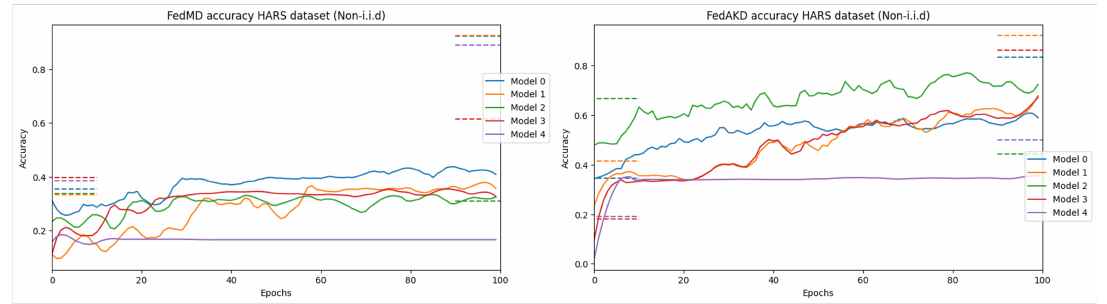
Figure 9. Ten heterogeneous models are trained in an FL setting using FedAKD (ours) and FedMD [26]. From left to right, the plots show five models (out of ten) trained collaboratively using FedAKD and FedMD, respectively, under the non-i.i.d case. It can be observed that models achieve better using our method. The five models shown here are the first five models in Table 4. The dashed line to the left and the right of each graph represent models’ performance on their local private dataset and models’ performance on all the local datasets combined, respectively. In all exper- iments, every client has 20 samples only per activity (as shown in Figure 6) as his D i , and | D p | = 100. The lines are smoothed using the Sav–Gol filter to show the trend more